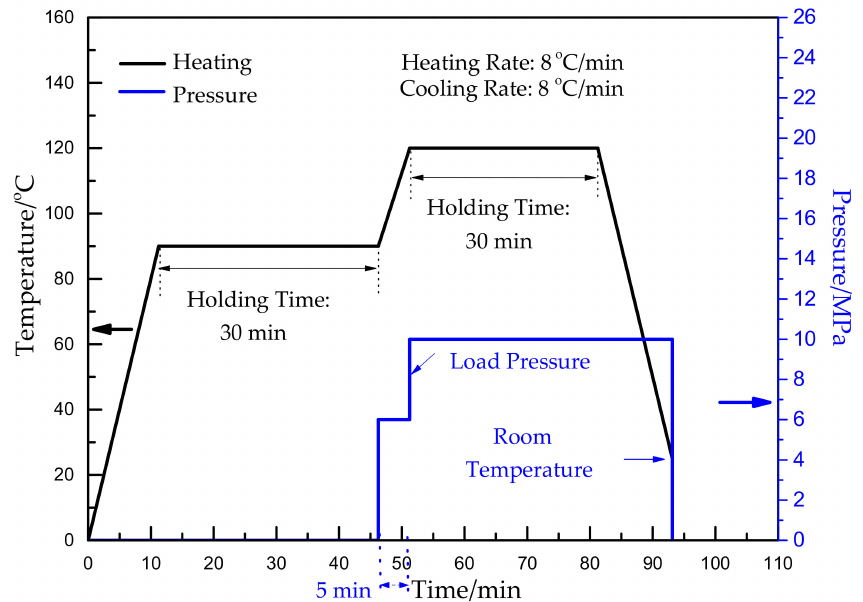
Figure 6. Subsection heating and pressurization schemes of the molding process.